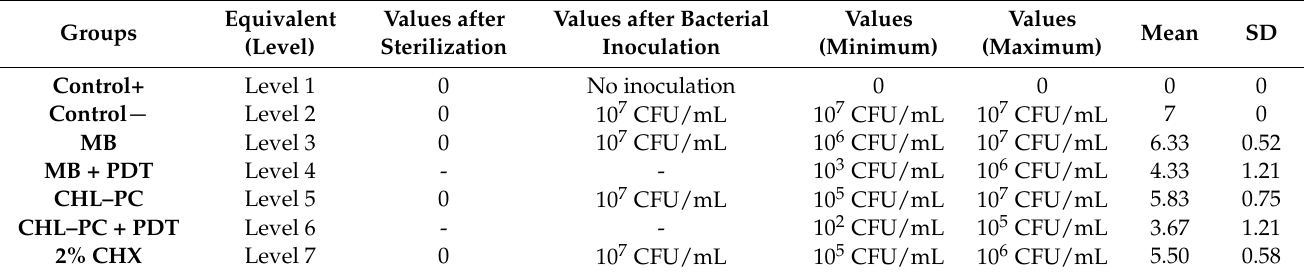
Table 1. The bacterial colony counts in different phases of the experiment (after sterilizing the samples, after inoculating the bacterial suspension, and after applying the treatments); the minimum and maximum values of the resulting bacterial colonies are reported, along with the means and standard deviations for all